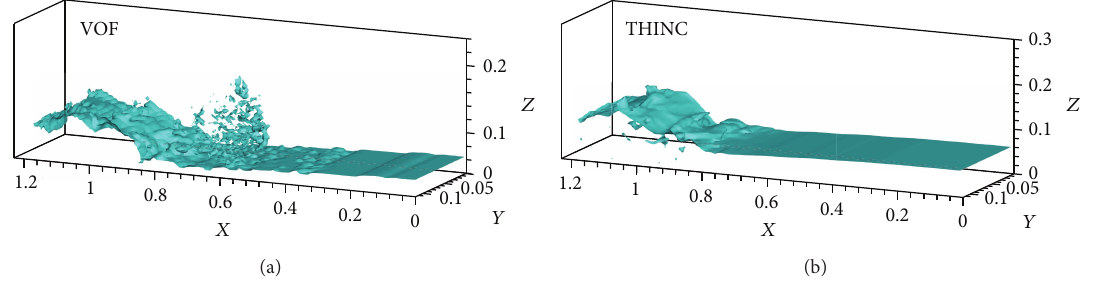
Figure 5: Snapshots at 𝑡 = 1.1 s of dam-break flow: original VOF (a) and THINC (b).